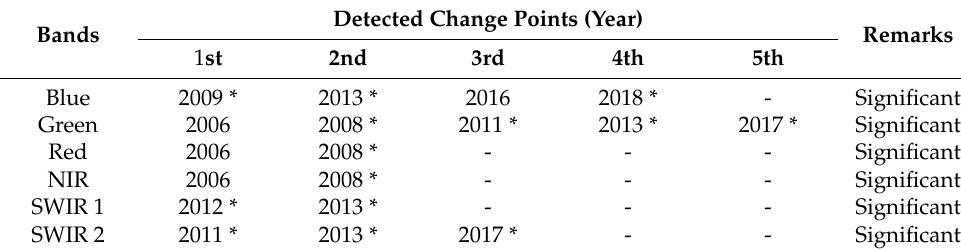
Figure 8. TOA reflectance data of virtual constellation over Libya 4 for blue, green, red, NIR, SWIR 1, and SWIR 2 band with fitted trend lines before and after turning points. Table 9. Change point detection by sequential version of the Mann–Kendall test for Libya